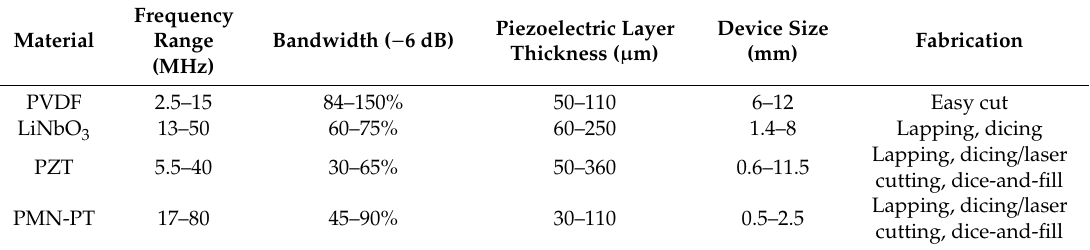
Table 3. Key findings of TEM pMUTs for endoscopic PAI applications.